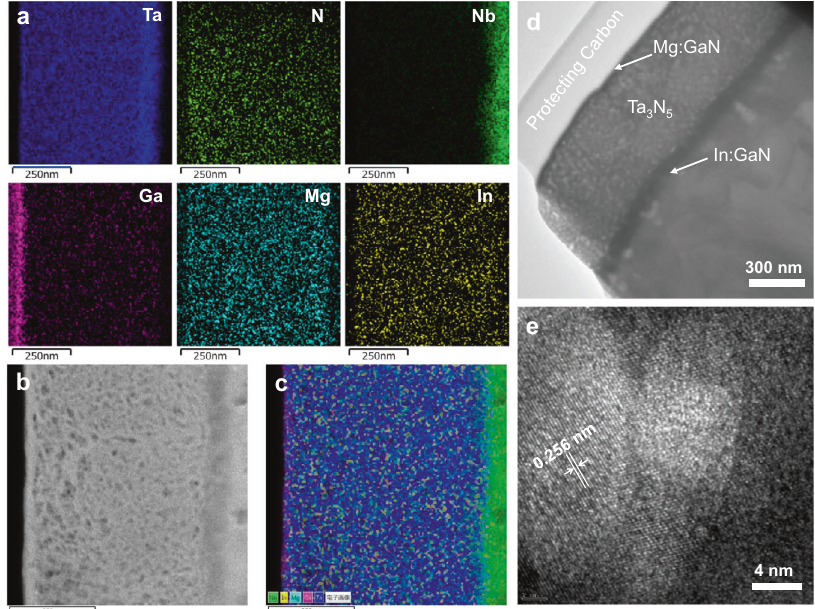
Fig. 2 Structural properties of In:GaN/Ta 3 N 5 /Mg:GaN heterostructure thin fi lm on Nb substrate. a Cross-sectional STEM-EDS elemental mappings of Ta, N, Nb, Ga, Mg, and In. b Annular dark- fi eld STEM image of the cross section of the sample. c Overlapping the AFD STEM image with the EDS mappings of the metallic elements. d Bright fi eld TEM image of the fi lm. e HRTEM image showing the lattice fringes of Ta 3 N 5 with a spacing of 0.256